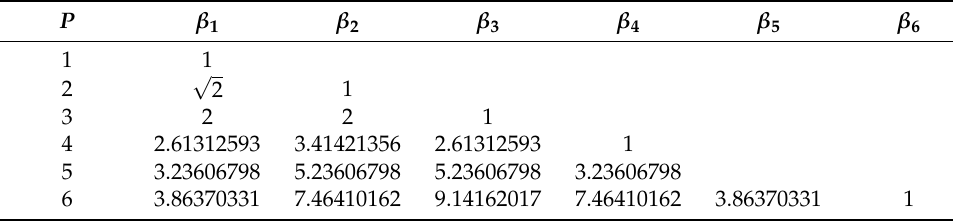
Table 1. Coefficient of the lowpass Butterworth filter in the model